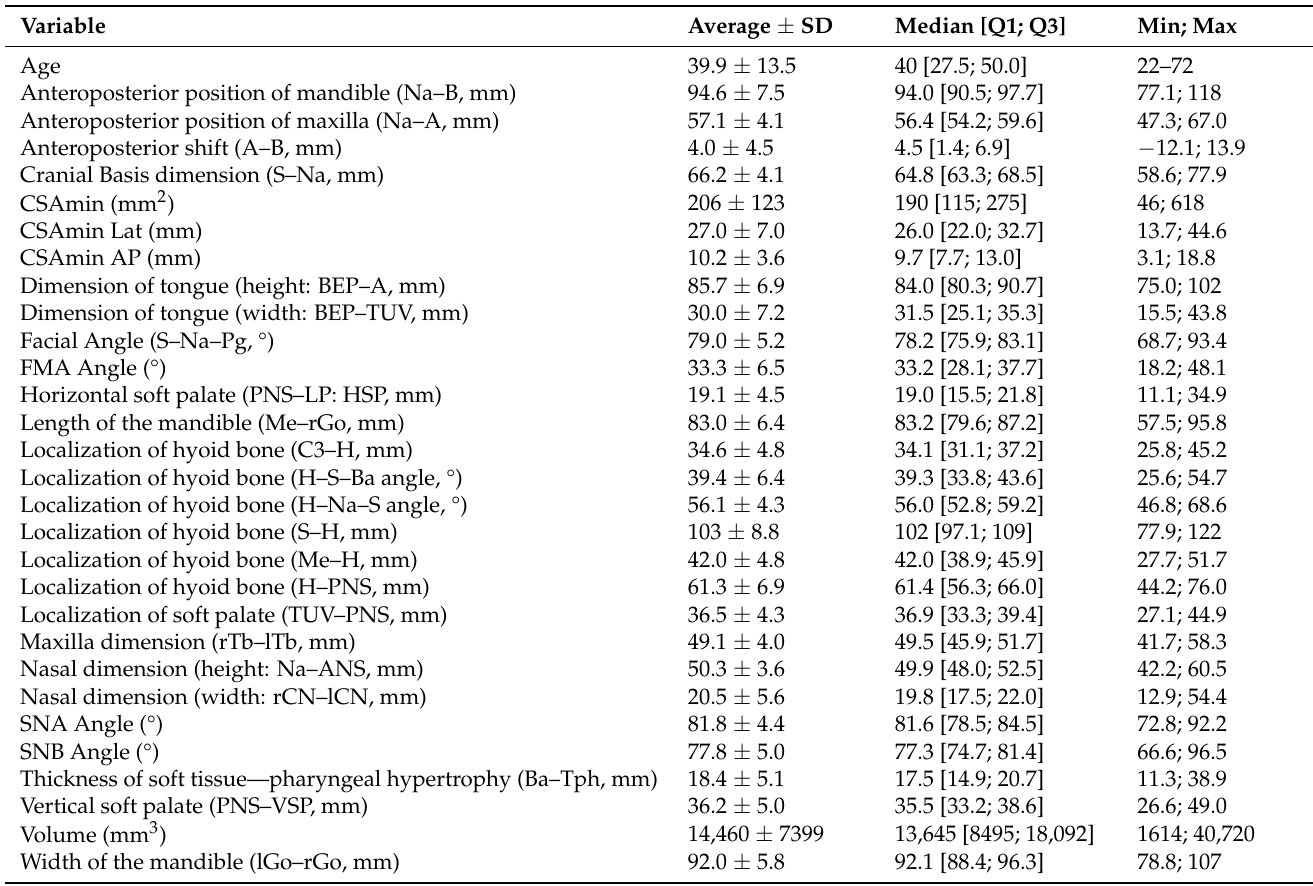
Table 5. Descriptive analysis of each variable using means, standard deviations, medians, and quartiles (N =